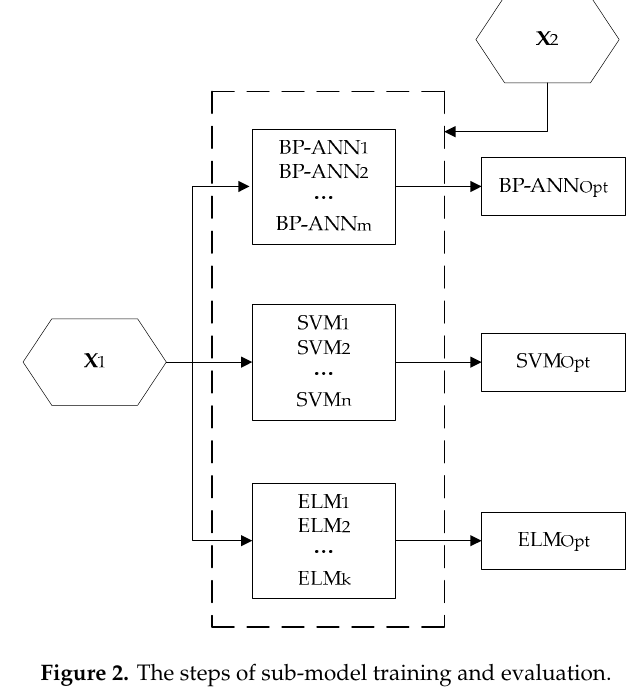
Figure 2. The steps of sub-model training and evaluation.